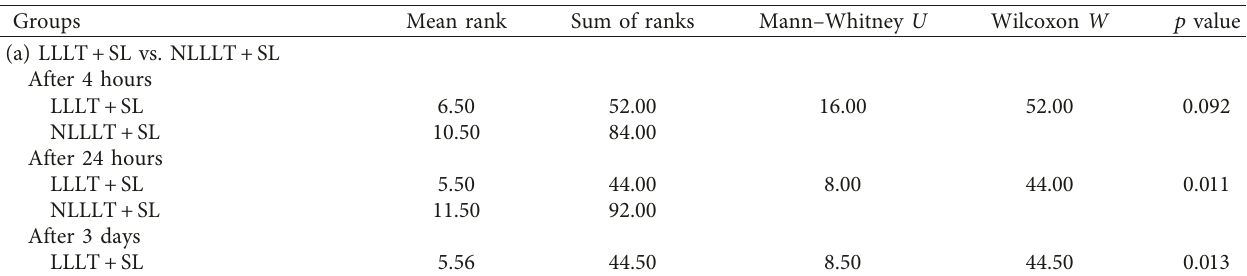
Table. 4: Step-by-step comparison between 2 groups using Mann–Whitney U